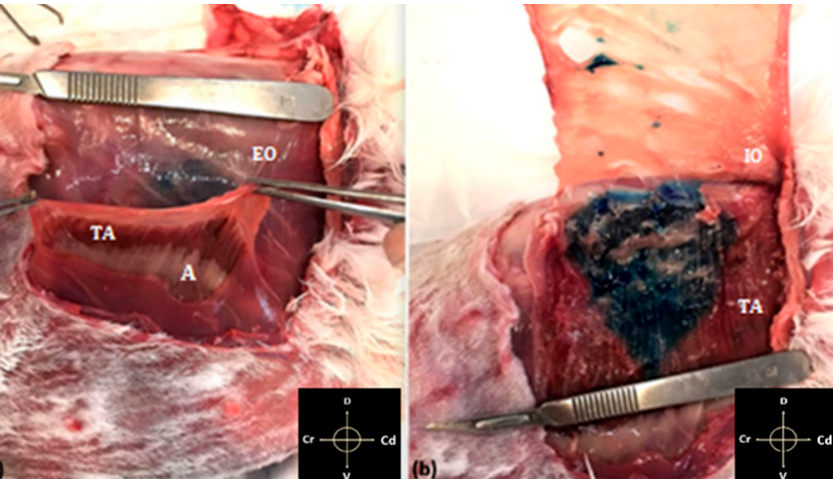
Figure 6. ( a ) Removal of the external and internal oblique muscles. It is possible to observe the aponeurotic fascia (A) of the underlying rectus abdominis and ventral portion of the transverse abdominis muscles (TA); ( b ) complete dissection of the internal (IO) and external oblique (EO) muscles. It is possible to observe the characteristic orientation of the muscle fibres of the transversus of the abdomen. The methylene blue has been correctly inoculated, and the stained muscle tissue is visible. Arrows indicate cranial (Cr), caudal (Cd), dorsal (D) and ventral (V) directions respectively. Table 1. Height and length (mean ± SD) of all hemiabdomens (H abdomen , L abdomen ) and of stained area (DV spread ; CC spread ) in millimetres (mm). The percentage of height (H methyl , %) and length (L methyl , %) of the stained area and the overall area of the spread (Area stained, mm 2 ) were also calculated and reported in the table.